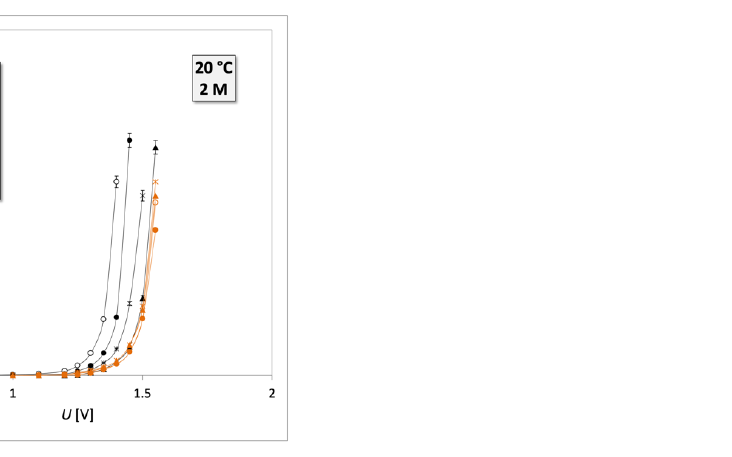
Figure 6. Electro-oxidation curves of Syntanol DS-10 detergent (orange lines) and waste engine oil emulsion (black lines) at the temperature of 20 °C in a 2 M aqueous solution of H 2 SO 4 , for various concentrations of detergent and emulsion (0.005%, 0.010%, 0.030%, and 0.060% of reactor volume).